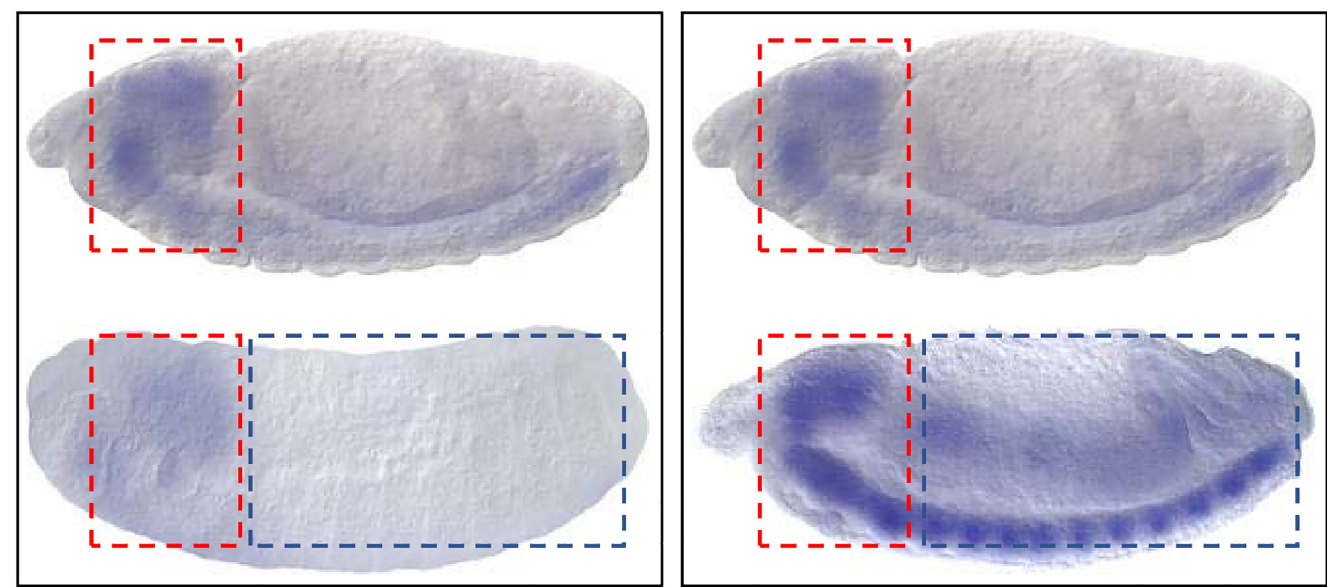
Fig 6. The comparison of expression pattern of CG12054 and its targets, lid and CG31108 . As arranged in the input, the TF ( CG12054 )’s expression image is put above that of its target, lid (left) or CG31108 (right). Red and blue dotted squares frame the head and body of Drosophila ’s embryo, respectively. Fig 7(B), i.e. the occlusion map, where the black regions denote no impact on the output prob-